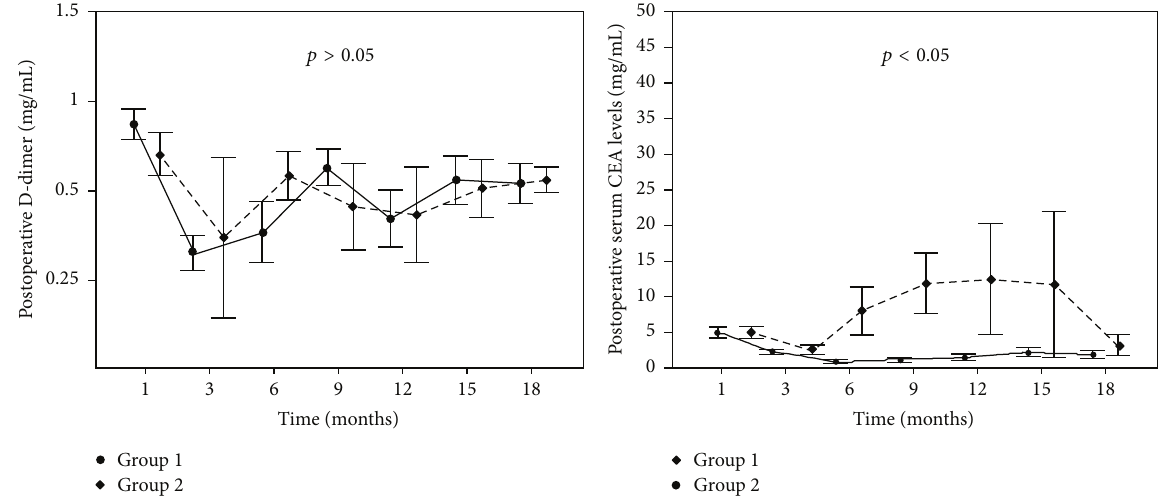
Figure 1: Relationship between metastasis and postoperative D-dimer and CEA levels of